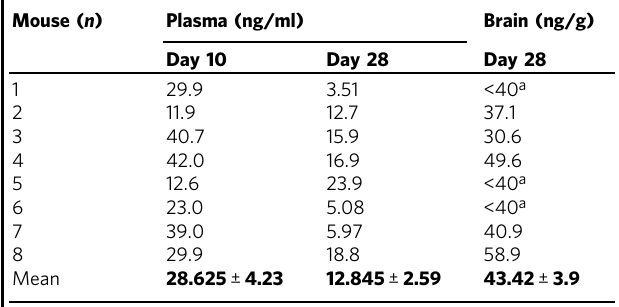
Table 5 Felodipine plasma and brain concentration in